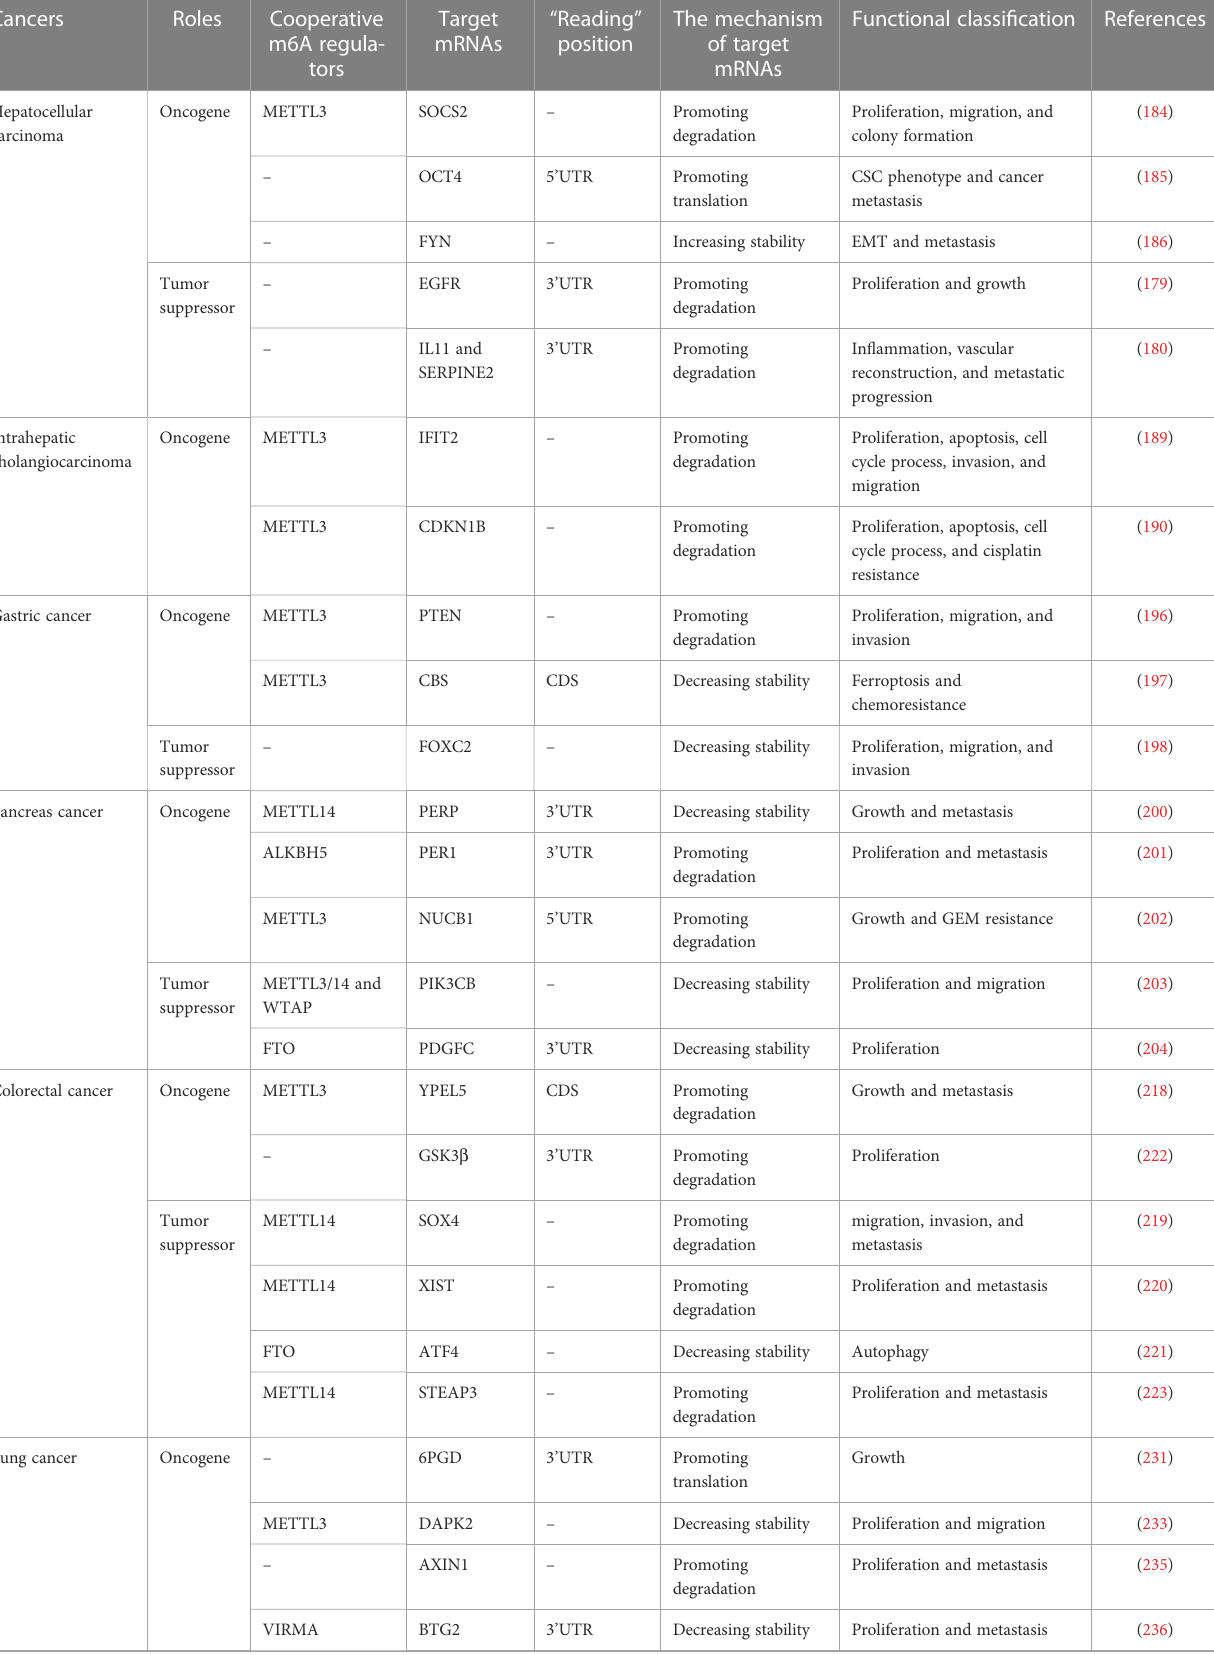
TABLE 2 The role of the YTHDF2 in